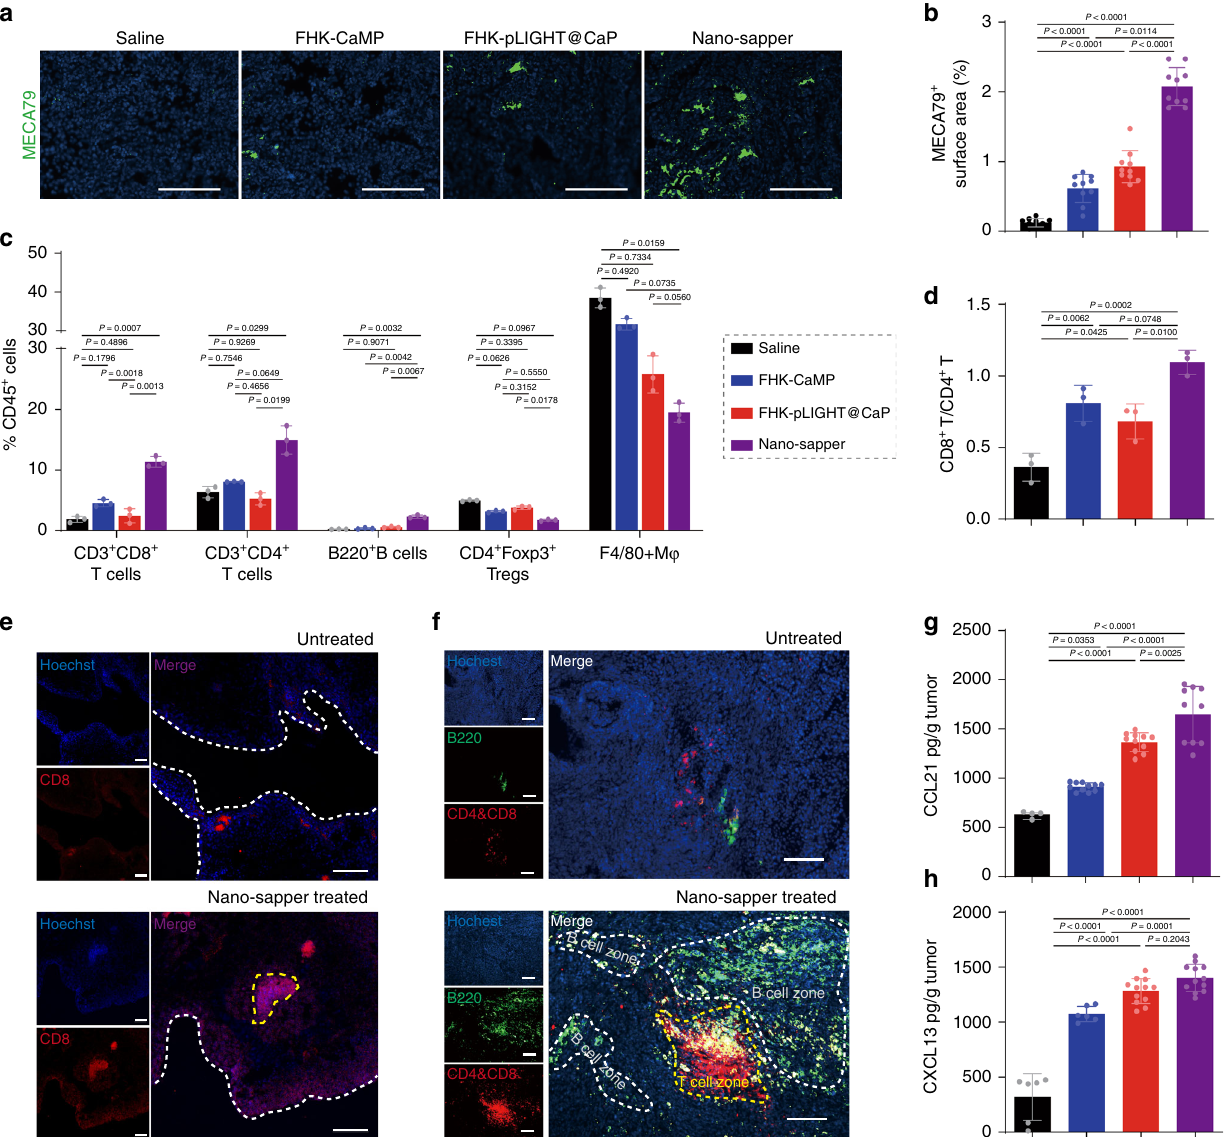
Fig. 6 Nano-sapper enhanced CTLs in fi ltration and initiated the TLSs formation in TME. a , b Tumor slices were stained for MECA79 and analyzed by ImageJ. Scale bars, 100 μ m. n = 10 section images from three mice. The experiments were repeated three times independently. c , d Flow cytometry analysis of immune cells within TME ( n = 3 mice). e , f Nano-sapper treatment promoted T cell penetration into deeper region of PDAC and induced the formation of TLSs. Scale bars, 100 μ m. Data were pooled from three independent experiments. g , h Chemoattractants involved in lymphocyte recruitment were elevated within TME. (For CCL21, Saline, n = 4 mice; FHK-CaMP, n = 11 mice; FHK-pLIGHT@CaP, n = 11 mice; Nano-sapper, n = 10 mice. For CXCL13, Saline, n = 6 mice; FHK-CaMP, n = 6 mice; FHK-pLIGHT@CaP, n = 12 mice; Nano-sapper, n = 12 mice.) Data are presented as mean ± s.d. One-way ANOVA with Bonferroni multiple comparisons post-test was used for ( b ), ( c ), ( d ), ( g ), and ( h ). Error bars represent